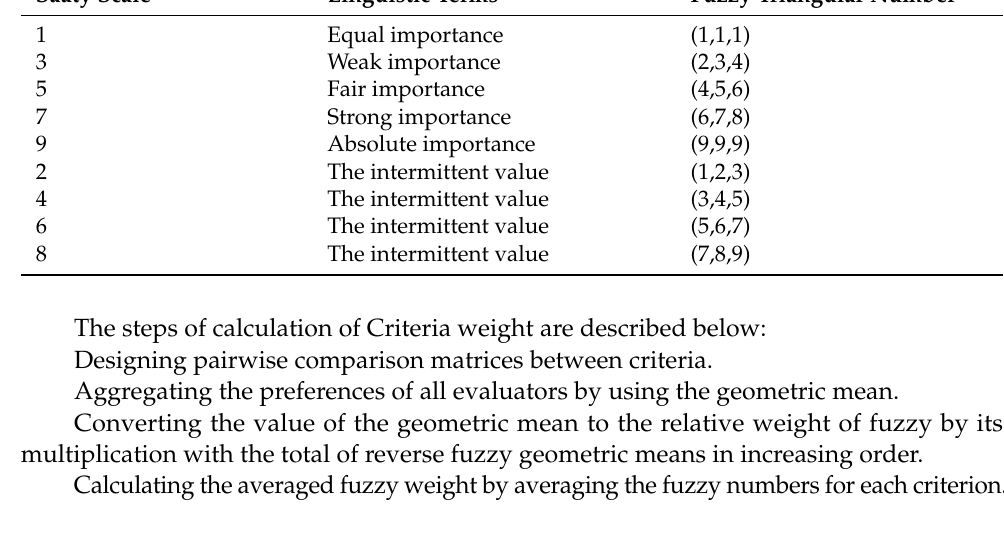
Table 1. The scales of pairwise comparison [44] . Table 2. Terms used in linguistics and their related triangular fuzzy scale. Saaty